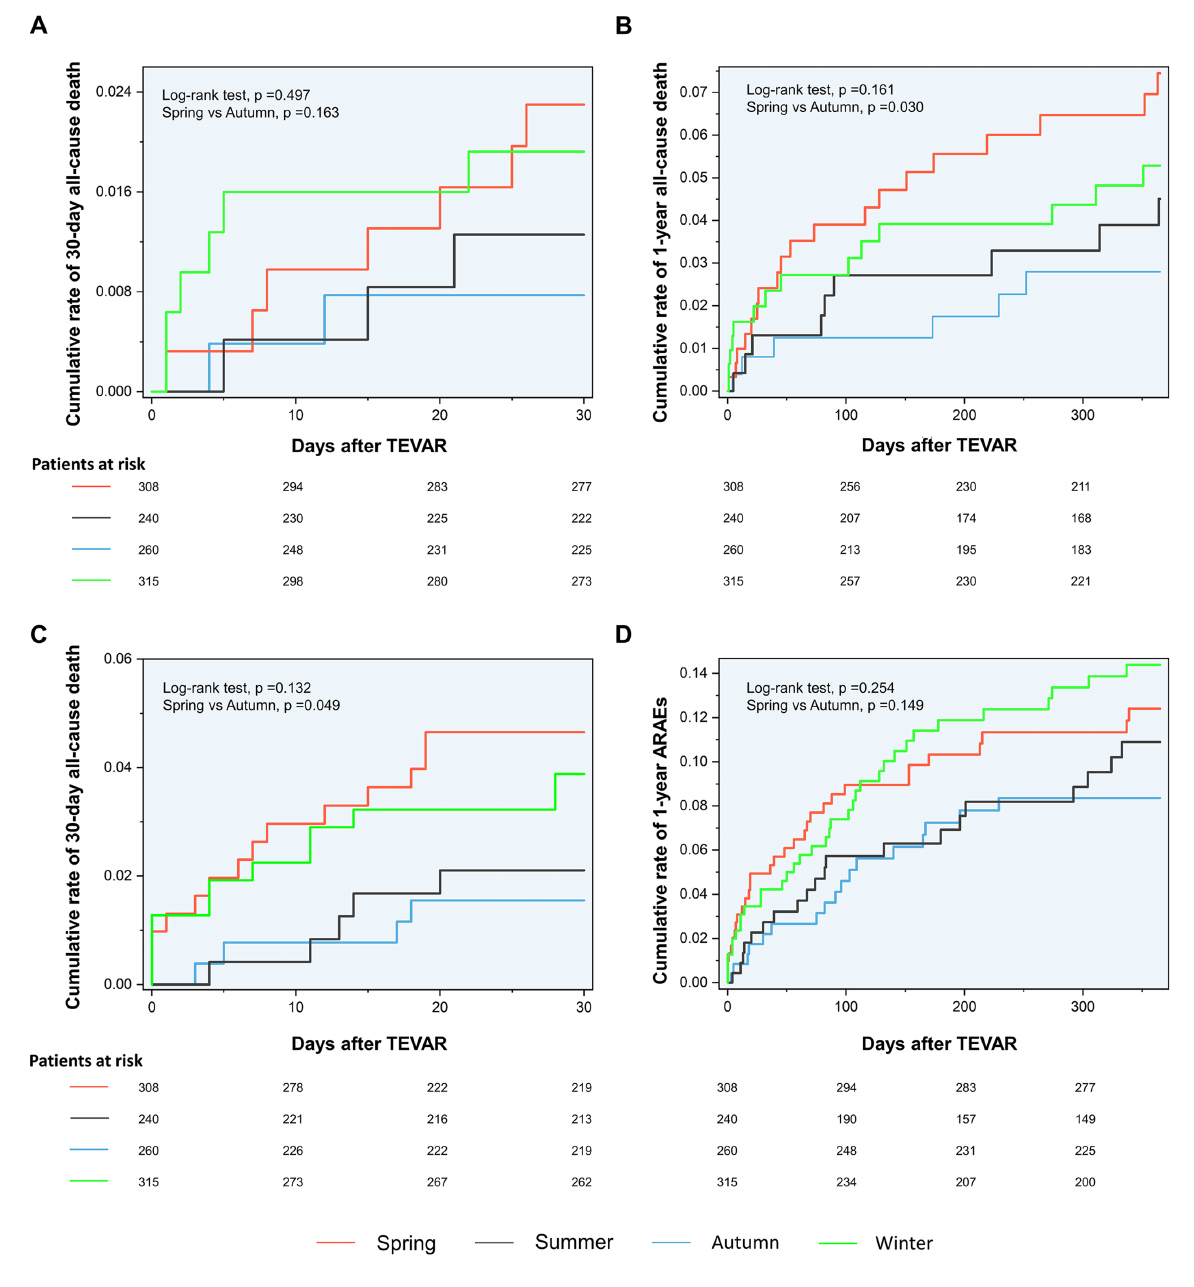
FIGURE 2 Associations of interventional dates with outcomes of TBAD patients. ( A ) Fitted curve of the data for logRRs for 30-day mortality against dates for TEVAR. ( B ) Fitted curve of the data for logRRs for 1-year mortality against dates for TEVAR. ( C ) Fitted curve of the data for logRRs for 30-day ARAEs against dates for TEVAR. ( D ) Fitted curve of the data for logRRs for 1-year ARAEs against dates for TEVAR. TBAD, type B aortic dissection; logRRs, log relative risks; ARAEs, aortic-related adverse events; CI, con fi dence